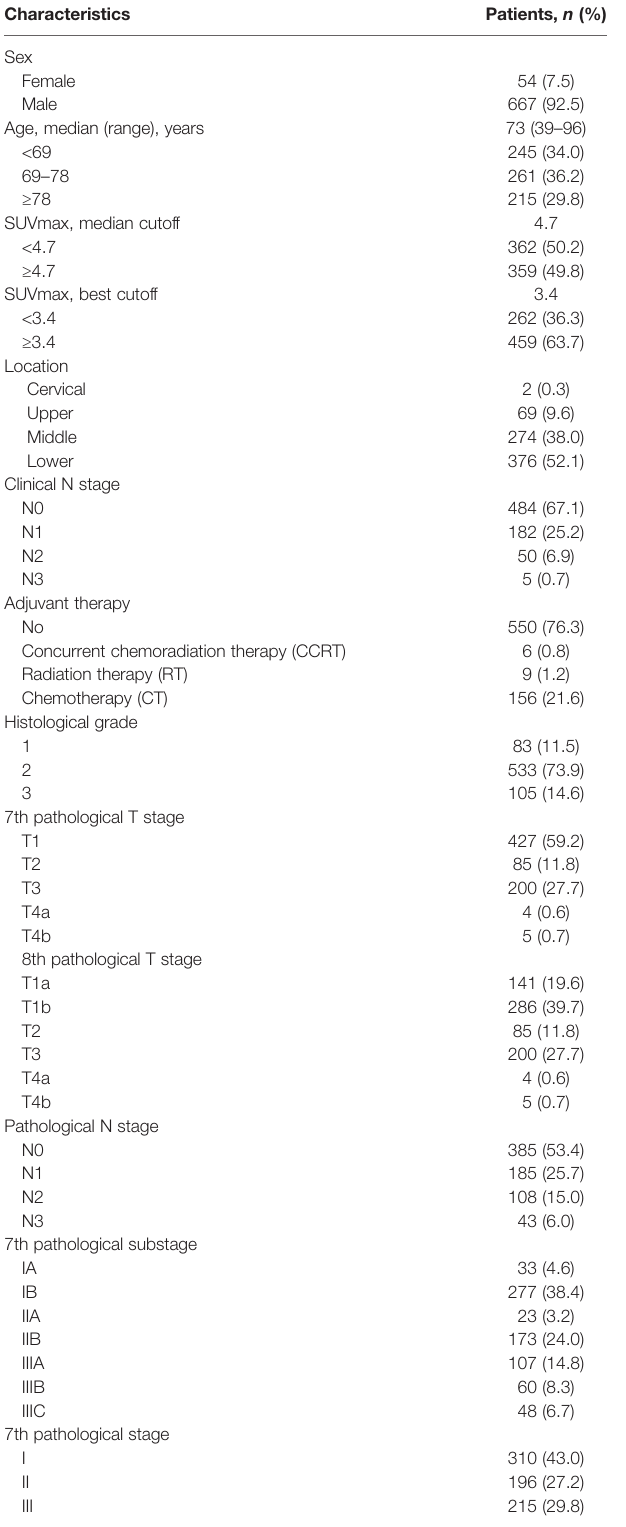
TABLE 1 | Demographic and clinical characteristics of the patients with esophageal squamous cell carcinoma.